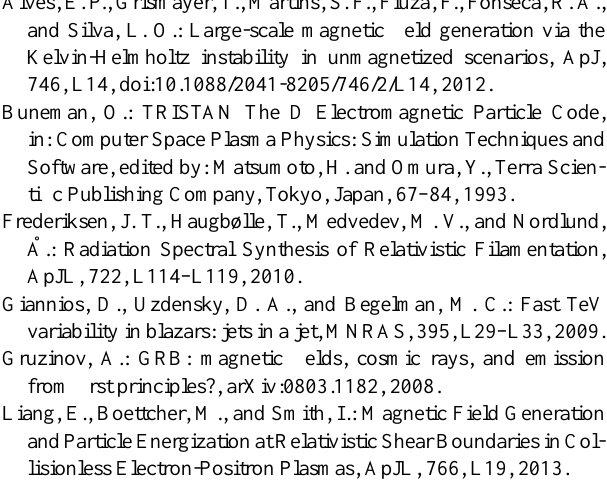
Fig. 6. The upper panel shows electrostatic mode solutions as a function of wavenumber, k , parallel to the flow direction. The real part, ω R , and imaginary part, ω I , of the frequency are indicated by the solid and dashed lines, respectively. The lower panel shows the phase velocity, γ w β w , where β w = ω R /kc